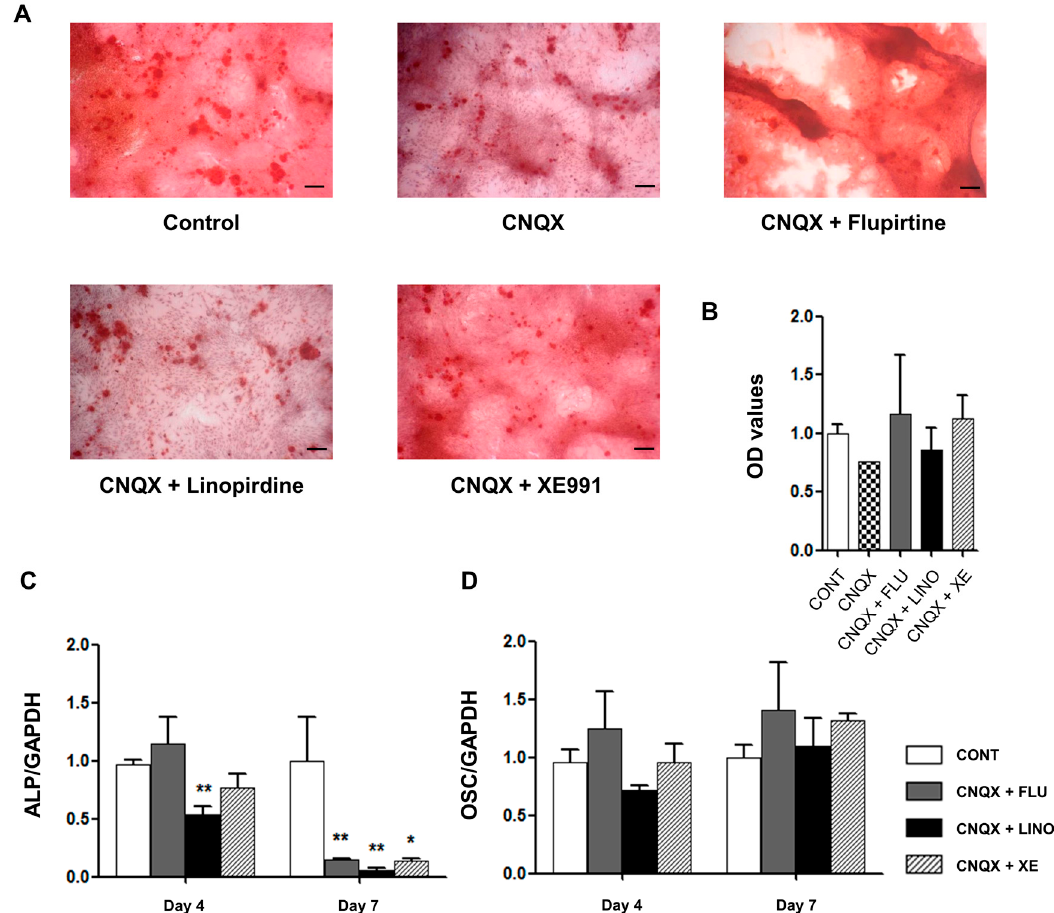
Figure 11. Suppressive effect of CNQX (6-cyano-7-nitroquinoxaline-2,3-dione), an AMPA ( α -amino-3-hydroxy-5-methyl-4-isoxazolepropionic acid)/kainite receptor antagonist, on osteoblastic differentiation promoted by K V 7.3 blockers. ( A ) Alizarin Red S staining showed that CNQX (50 μ M) co-applied with flupirtine (30 μ M), linopirdine (30 μ M), or XE991 (10 μ M) produced amounts ofcalcium deposits similar to those of the controls ( n = 3). ( B ) The OD values are shown parallel to Alizarin Red S staining results. The relative mRNA expression levels of osteoblastic differentiation markers, including ALP and OSC, were measured with qRT-PCR and normalized against GAPDH (glyceraldehyde 3-phosphate dehydrogenase) expression ( n = 3). ( C ) At day 4, CNQX treatment with XE991 significantly reduced the ALP mRNA expression. At day 7, CNQX with flupirtine, linopirdine, or XE991 attenuated the ALP level. ( D ) CNQX treatment with flupirtine, linopirdine, or XE991 showed no significant changes in the OSC levels. Data are presented as mean ± SEM. * p < 0.05 and ** p < 0.01. Scale bar represents 100 μ m. CONT: non-treated controls; FLU: flupirtine; LINO: linopirdine; XE: XE991; ALP: alkaline phosphatase; OSC: osteocalcin; OD: optical density.